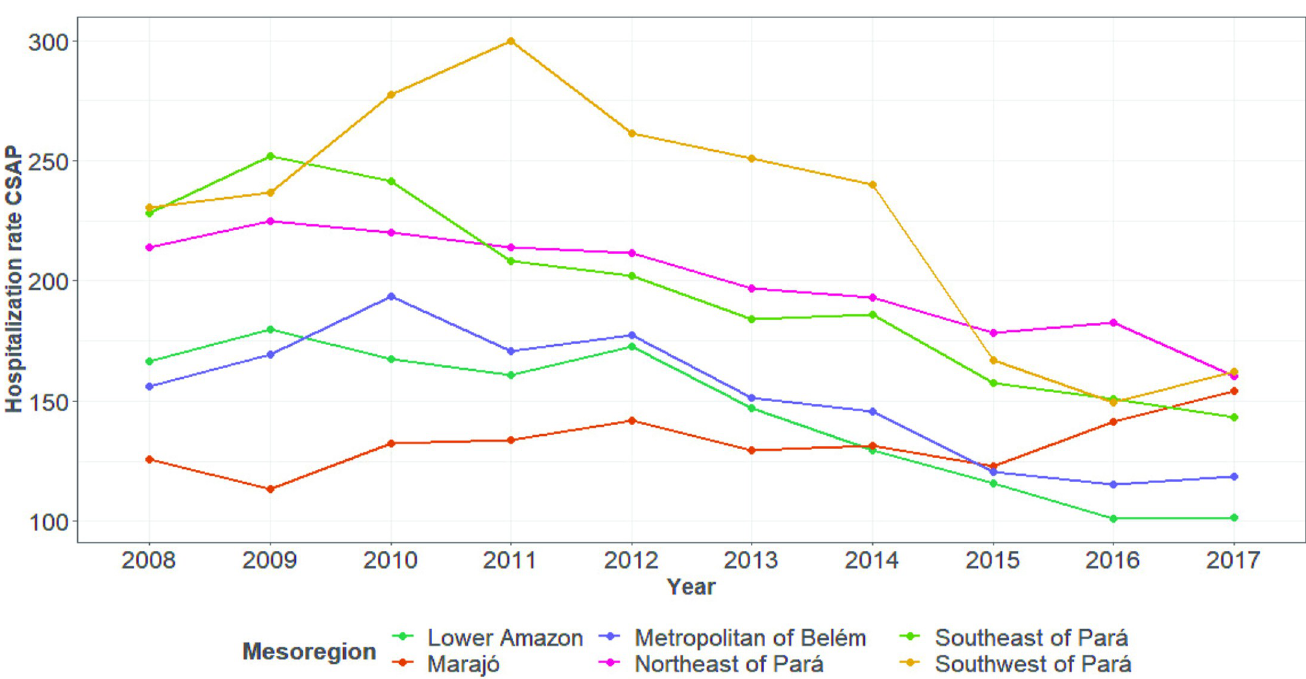
Fig 3. Evolution of the rate of hospitalizations for ambulatory care-sensitive conditions per mesoregion of Para´, 2008–2017. Source: SIH/DATASUS.